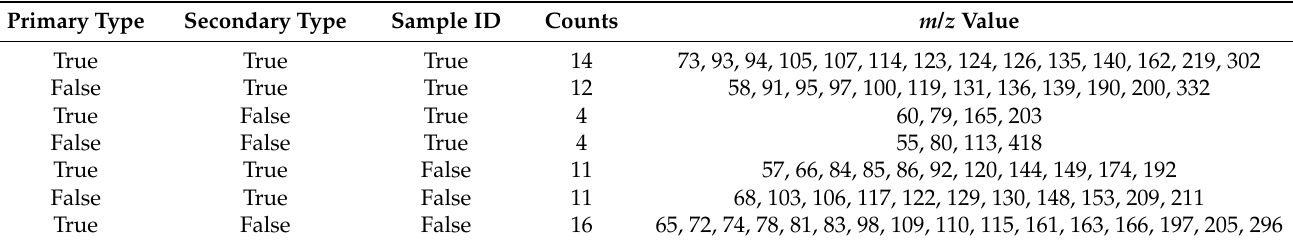
Table 5. Spectral features (ions) specific to classification problems using RUV-corrected